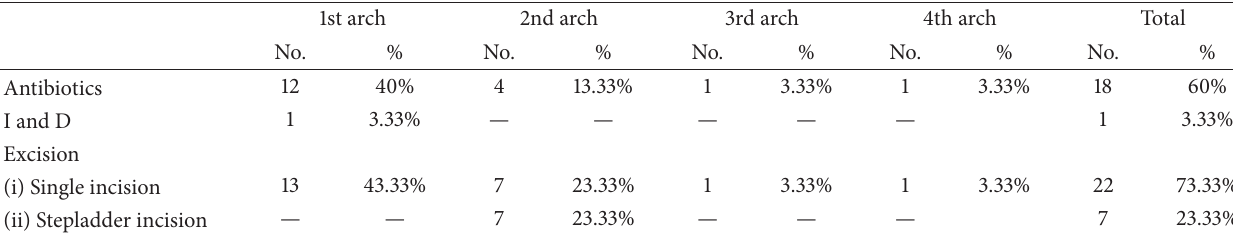
Table 4: Treatment.